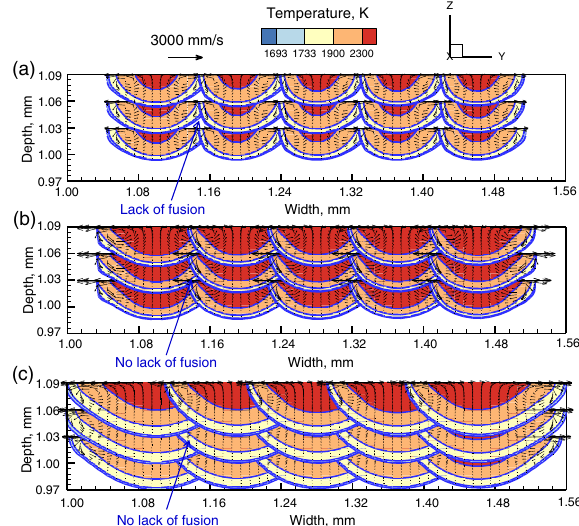
Fig. 7 Transverse view of fusion zones. The transverse views indicate lack of fusion during 3 layers 5 hatches PBF-L of ( a ) 60